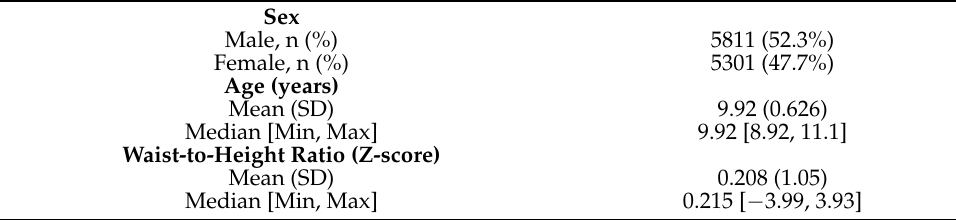
Table 1. Participant demographics and Waist-to-Height Ratio Z-score (N = 11,112).